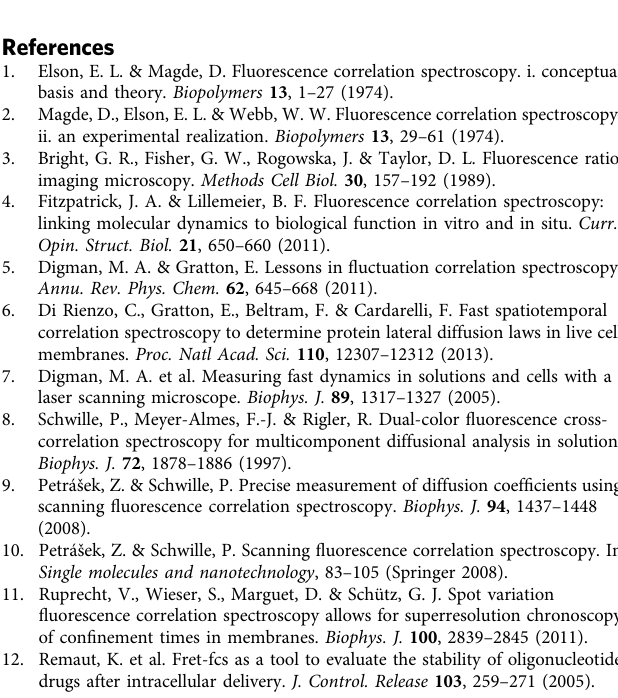
Data availability The data generated and analyzed in this study are freely available from the corresponding author upon request. Code availability Source code and GUI versions of the methods developed herewith are freely available to download at [https://cbp.asu.edu/content/steve-presse-lab] or [https://github.com/ sinajazani/F-CS].